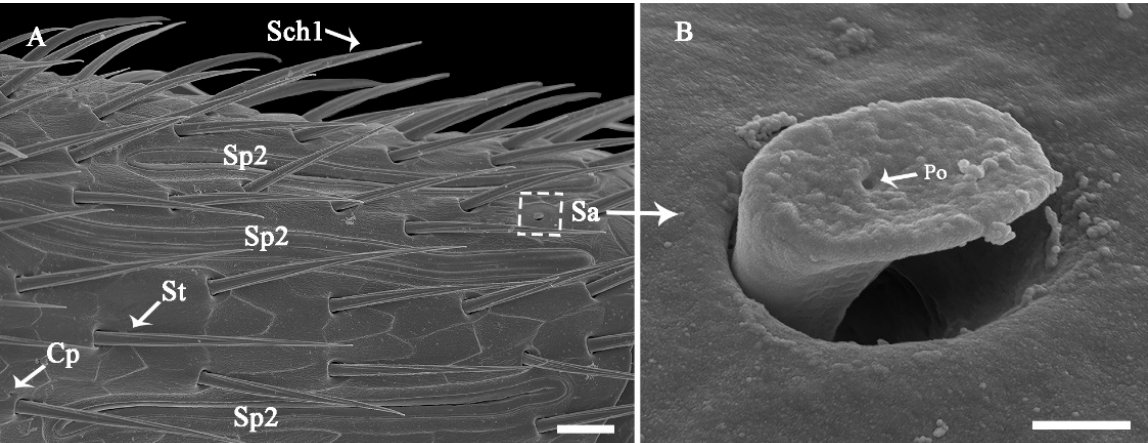
Figure 10. Fine morphology and distribution of antennal sensilla on flagellomere 20 of C. qinlingensis .